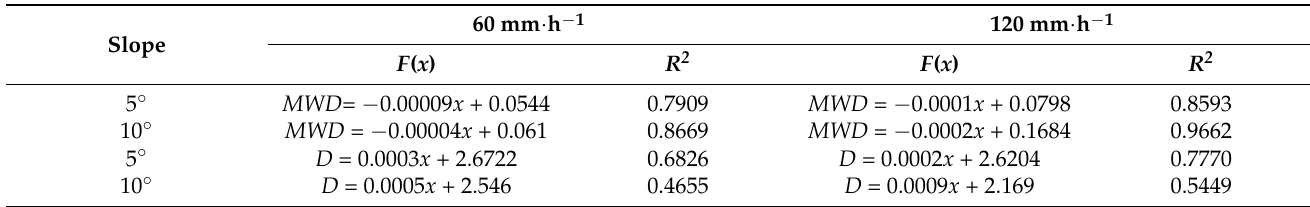
Table 5. Eroded sediment separation characteristic parameters as function of litter coverage